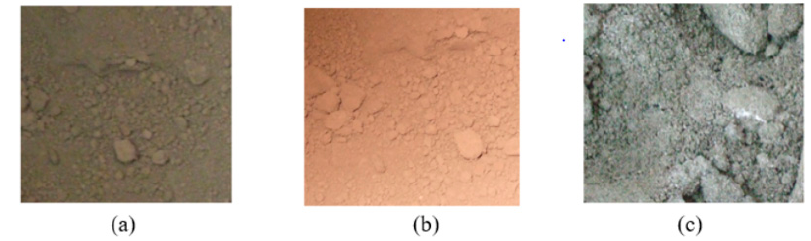
Figure 1. ( a ) Austenitic and ( b ) ferritic stainless steel and ( c ) slag.